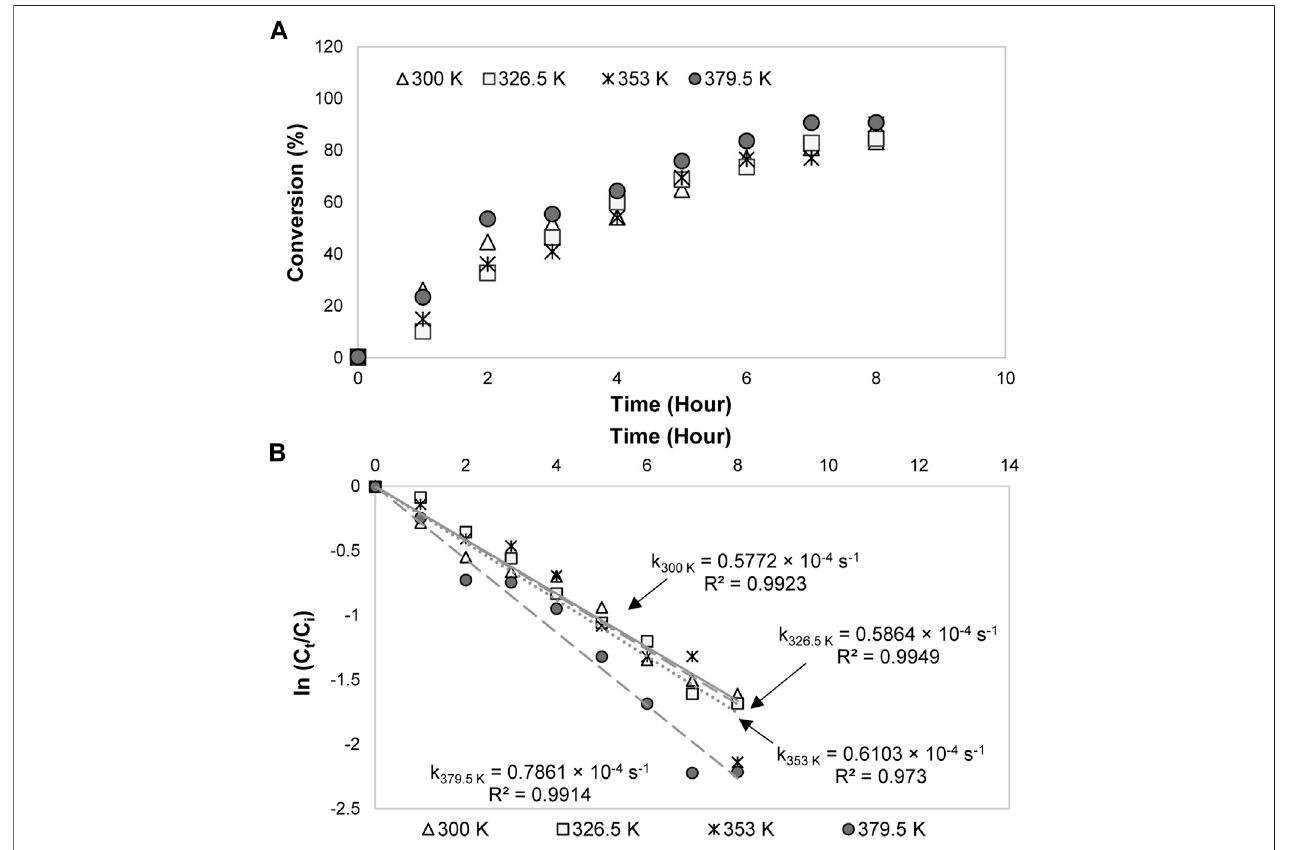
FIGURE 5 | (A) Glycerol conversion and (B) fi rst-order kinetics model for 0.3 mol/L of glycerol electrocatalytic reduction at different reaction temperatures.